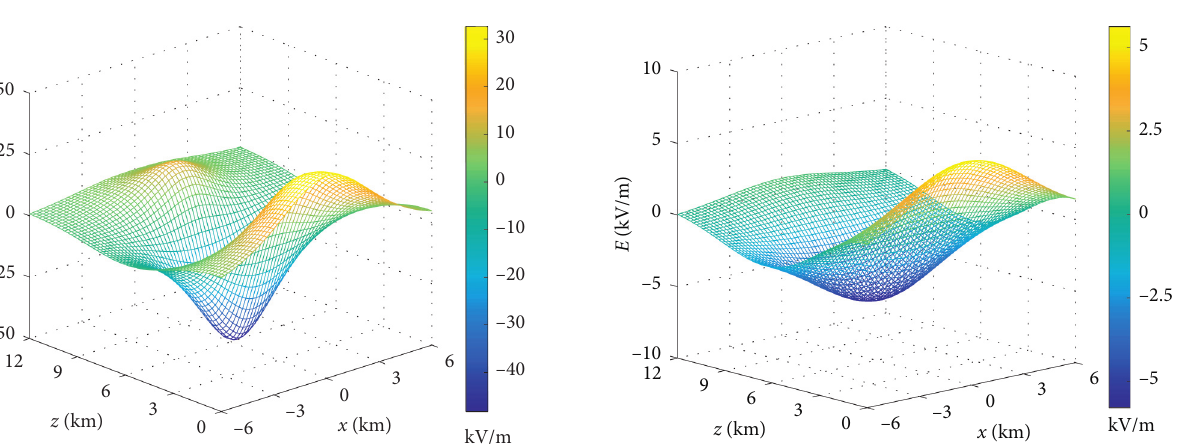
Figure 12: Electric field distribution on the longitudinal section while y �